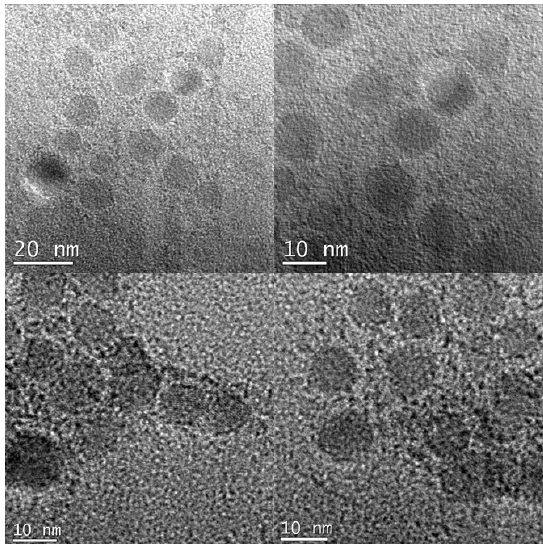
Figure 7. TEM images of the nanospheres of CdO.